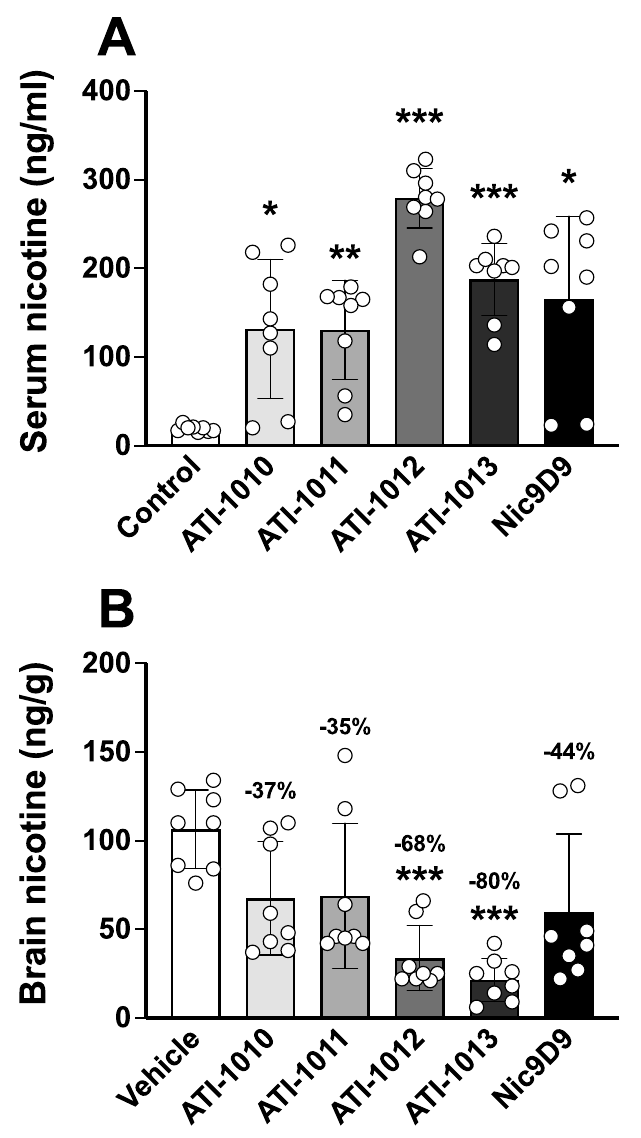
Fig 2. Functional in vivo activity of the 4 nic•mAbs with highest affinity for nicotine. Rats (n = 8/group) were pretreated i.p. with 20 mg/kg ATI-1010, 1011, 1012, 1013, NIC9D9, or PBS alone (vehicle) 2 h prior to i.v. dosing of 0.03 mg/kg nicotine via jugular catheter. Blood and brains were collected 3 min after drug administration. Data represent mean serum (Panel A) and brain (Panel B) nicotine concentrations in each group. � p < 0.05, �� p < 0.01, ��� p < 0.001 significantly different from vehicle. Numbers above bars represent the percent difference from controls. One-way ANOVA with Dunnett’s T3 multiple comparisons test was used to compare groups to vehicle. Data are expressed as mean ±